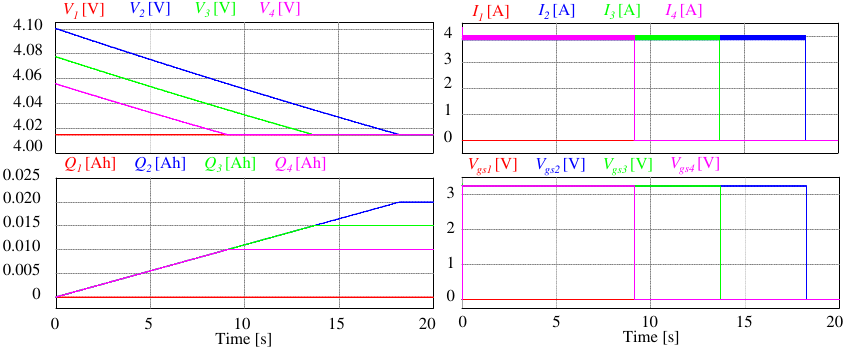
Figure 8. Equalization of a four-cell battery bank using the shunt switch scheme. Table 2. Comparative analysis of the passive